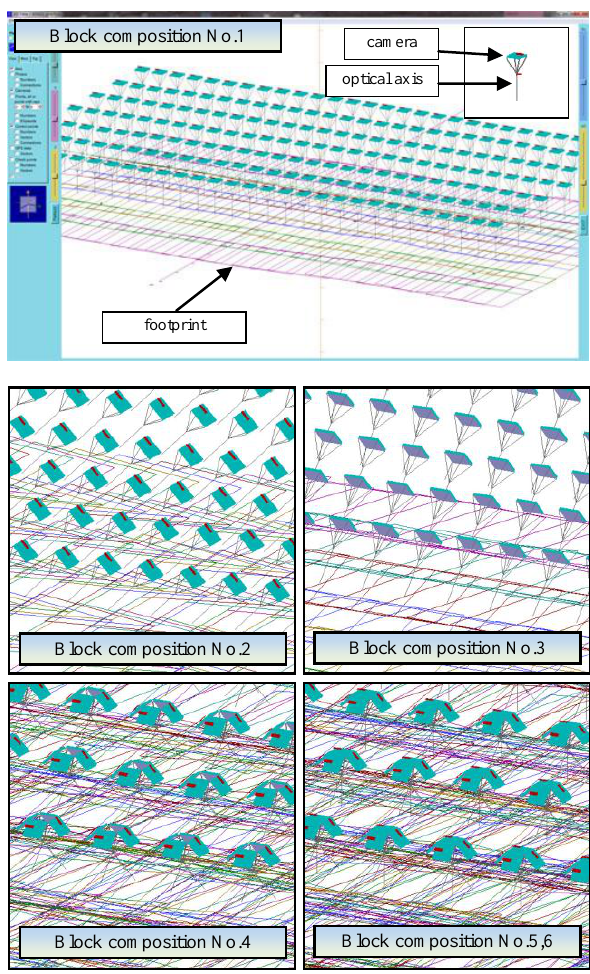
Figure 7. Block composition when calculating simultaneous adjustment